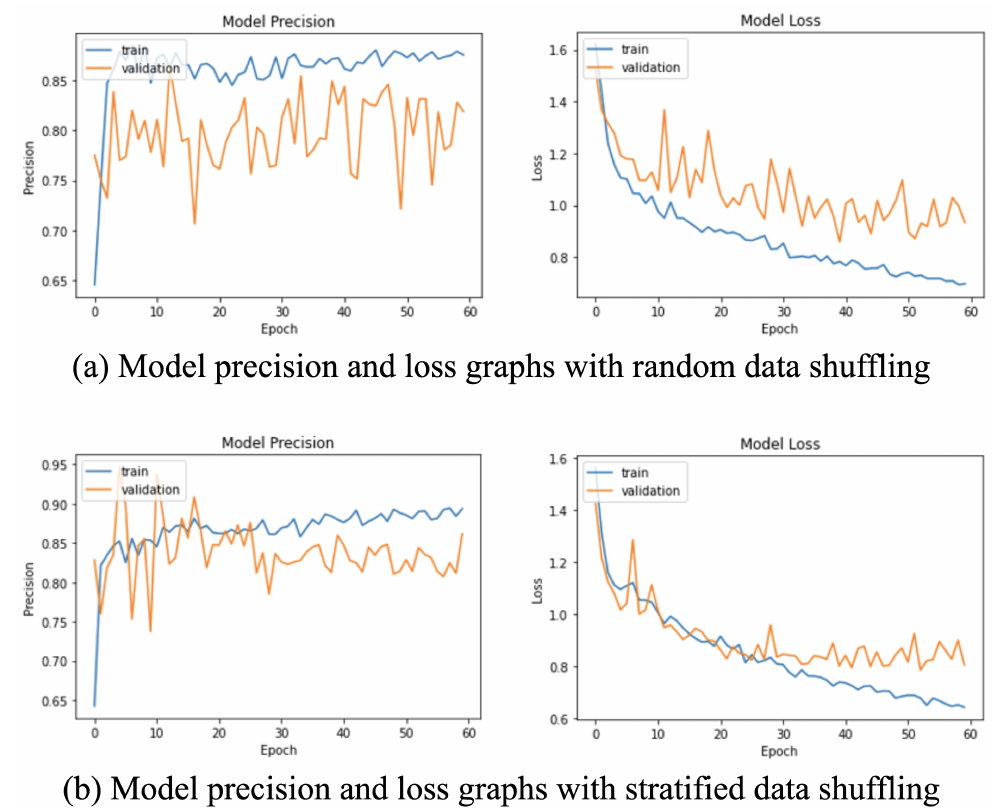
Figure 5. Model training graphs with ( a ) random and ( b ) stratified data shuffling. The stratified data shuffling results in less overfitting and a lower model loss. Hence, stratified data shuffling was used.